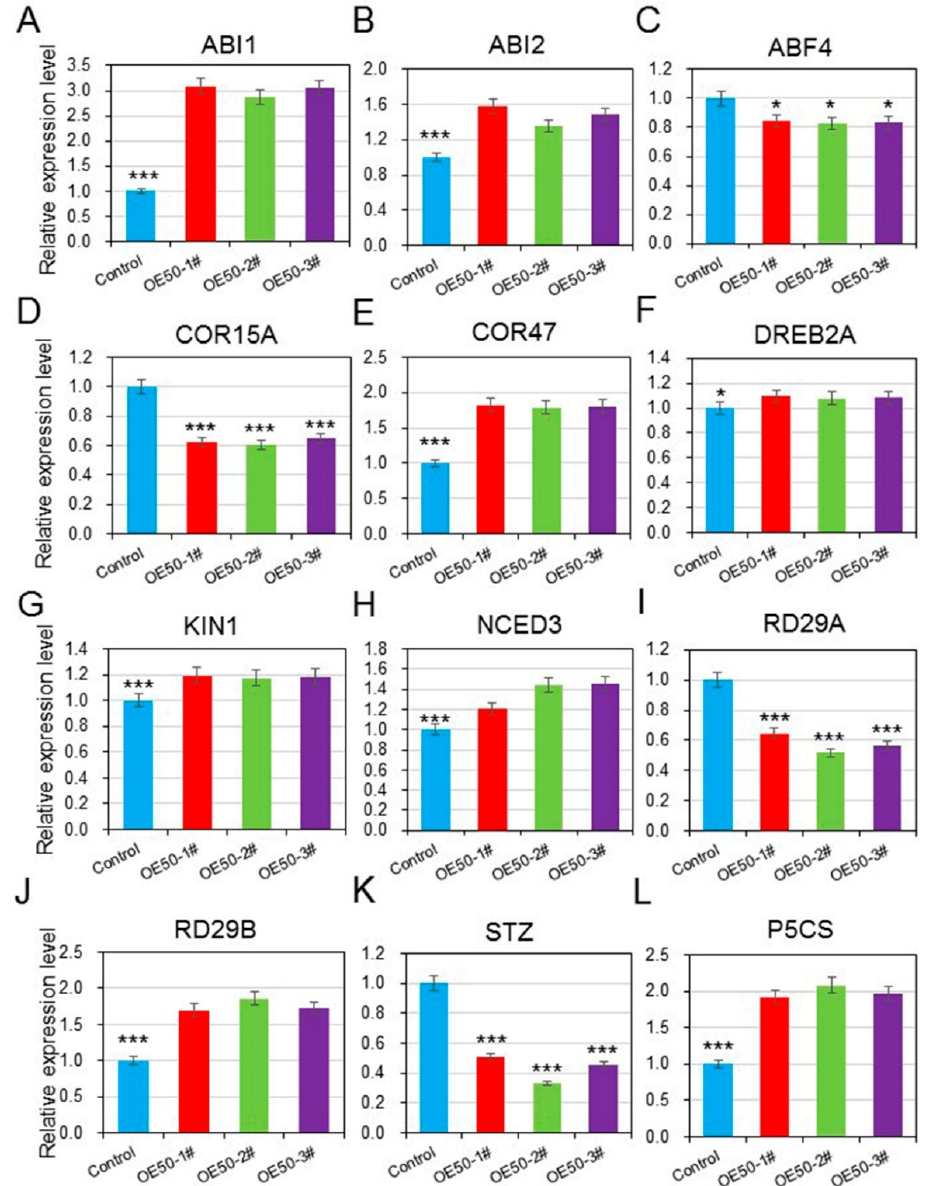
Figure 7. HcWRKY50 regulated the expression of ABA- and stress-related regulators. ( A – E ) ABA- mediated genes ( ABI1 , ABI2 , ABF4 , NCED3 , and COR47 ) were used to analyze ABA-responsive gene expression, ( F – L ) stress-responsive genes ( DREB2A , KIN1 , NCED3 , RD29A , RD29B , STZ , and P5CS ) were selected and their expression levels were evaluated in the OE50-1#, OE50-2#, and OE50-3# lines and in the control lines. Each value represents the mean ±SD of three independent replicates.